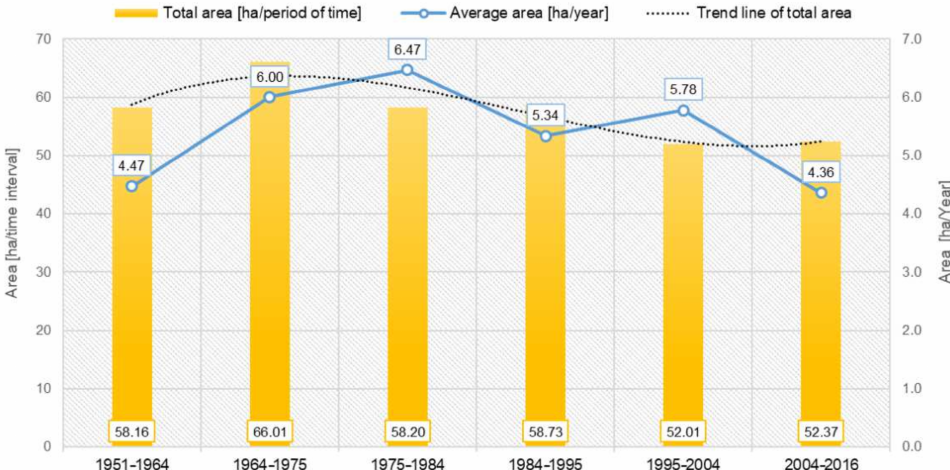
Figure 9. Total area of coastal change in subsequent time intervals.